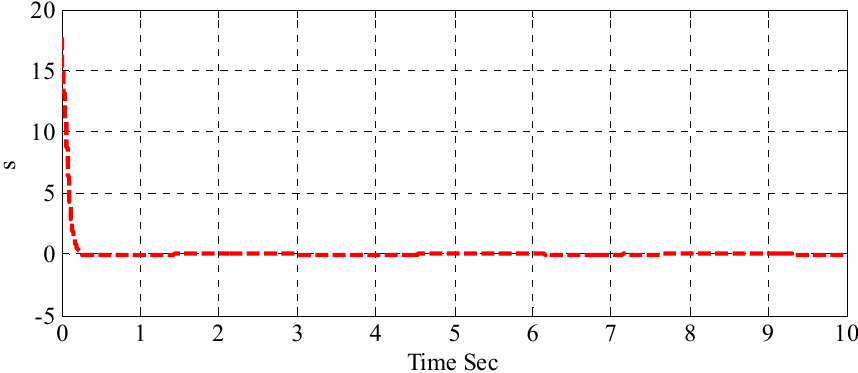
Figure 10. Sliding surface response based on adaptive sliding mode backstepping controller.